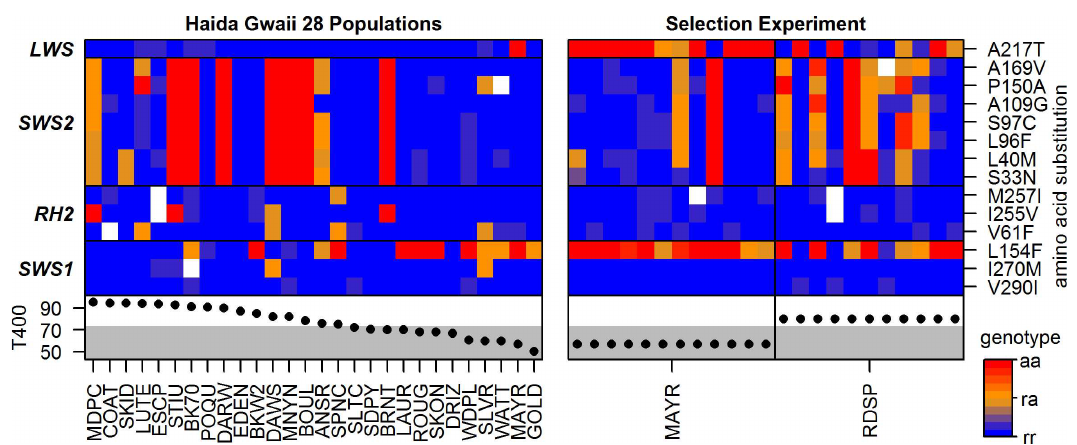
Fig 5. Cone opsin amino acid polymorphismsacrossthe HaidaGwaii stickleback radiation and selectionexperiment. Notethe highfrequencyandnearlyperfectlinkageof SWS2 aminoacidpolymorphisms. Columnsrepresentsingleindividuals perpopulation, rowsrepresentaminoacidpolymorphisms. Colorcodesshowthegenotypeprobabilitiesandaminoacidalleles relativeto the threespinesticklebackreferencegenome(S97C:reference= S, alternate = C; rr: homozygous for reference aminoacid,aa:homozygous for alternateaminoacid,ra: heterozygous genotype).Aminoacidpositionsarerelativeto the bovinerhodopsin protein.Lighttransmissionratiosat 400nm (T400)for the differentwaterbodiesaregivenin percentin the lowerpanels,withthegreyarearepresenting blackwater lakes[16].Genotypeprobabilities can befoundinS1 Data,T400 valuesin Table1.